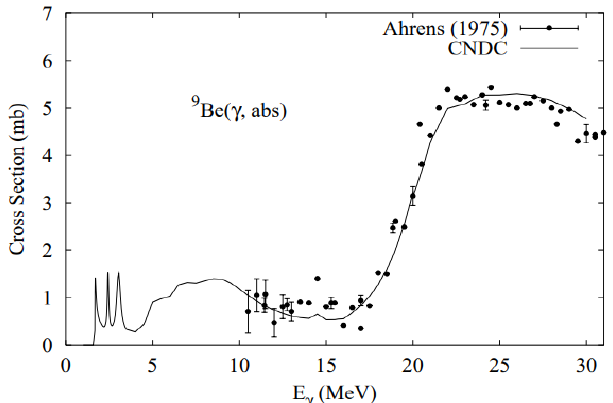
Fig. 5. The measured and the model calculation of the total cross-section of photoabsorption reaction 9 Be(γ, abs) [13]. in the ground or excited states (the three lowest well-separated levels of 8 Be are 3.04, 11.4, and 16.6 MeV). The thresholds of these channels are indicated in Table I. So for electron beam 8.7 MeV the three channels of reaction 9 Be(γ,n) are opened.